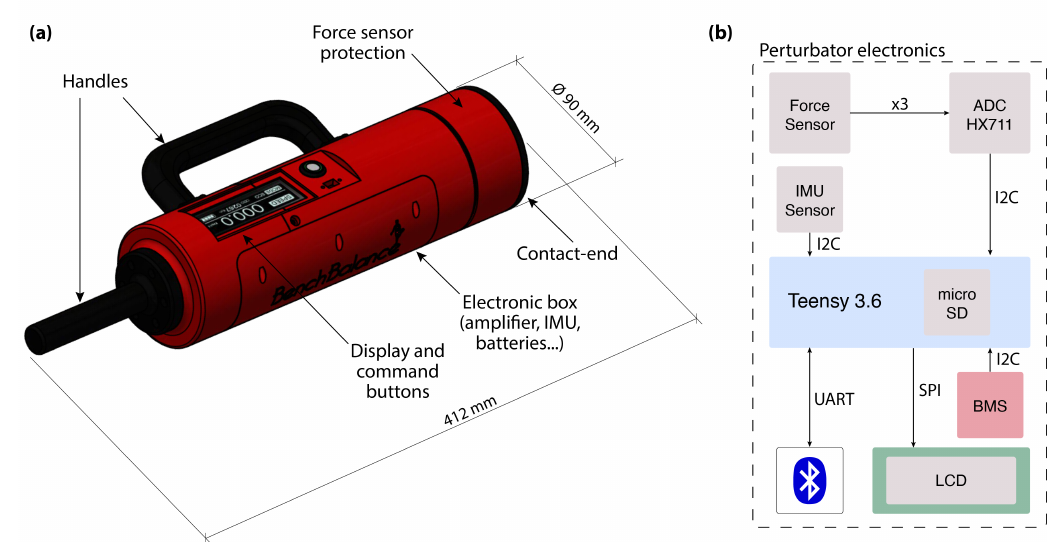
Figure 2. Portable perturbator overview: ( a ) CAD model and elements; ( b ) Electronic